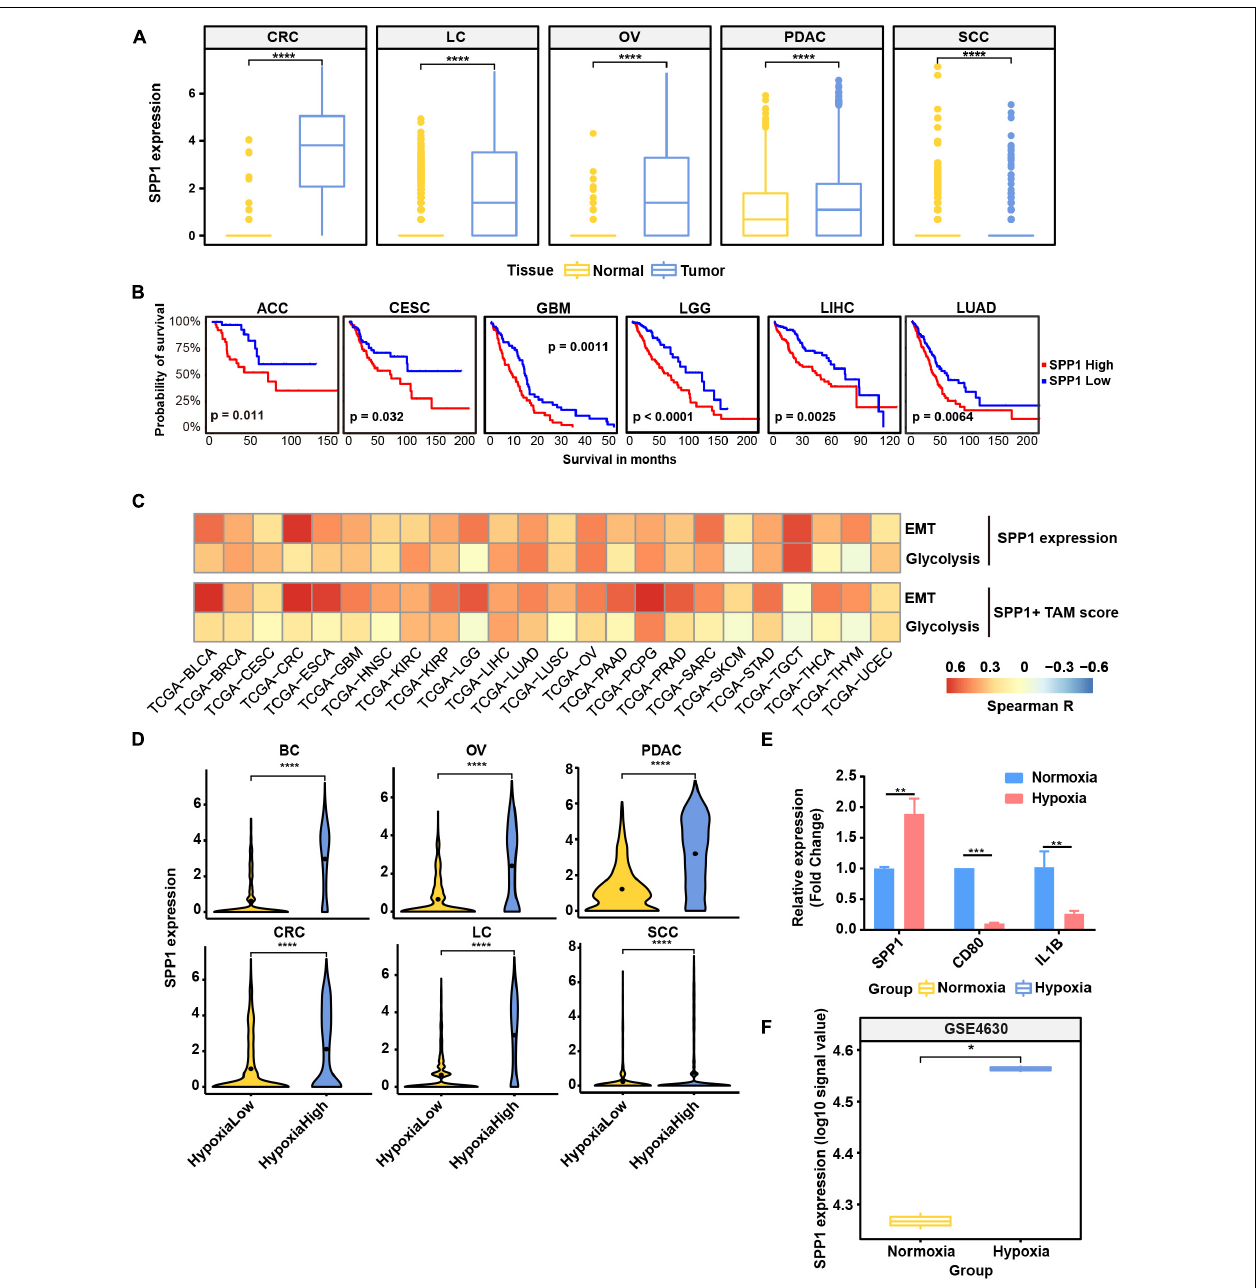
FIGURE 6 | SPP1 is related to poor prognosis and upregulated in hypoxia tumor microenvironment (TME) to promote malignant phenotype of cancer. (A) The expression of SPP1 in macrophage from tumor and normal samples. **** p ≤ 0.0001, two-sided Wilcoxon rank sum test. (B) The Kaplan–Meier overall survival curves of The Cancer Genome Atlas (TCGA) patients grouped by gene expression of SPP1 . (C) The correlation between SPP1 expression and SPP1+ TAM signature score with glycolysis score and EMT score in TCGA cancer samples. (D) Violin plot shows the SPP1 expression in hypoxia-high and -low macrophages in six cancer types. (E) Relative mRNA expression of SPP1 and M1 marker genes in THP-1-derived macrophage exposed to hypoxia (1% O 2 ) for 24 h. (F) The expression of SPP1 in macrophage exposed to hypoxia and normoxia from GSE4630